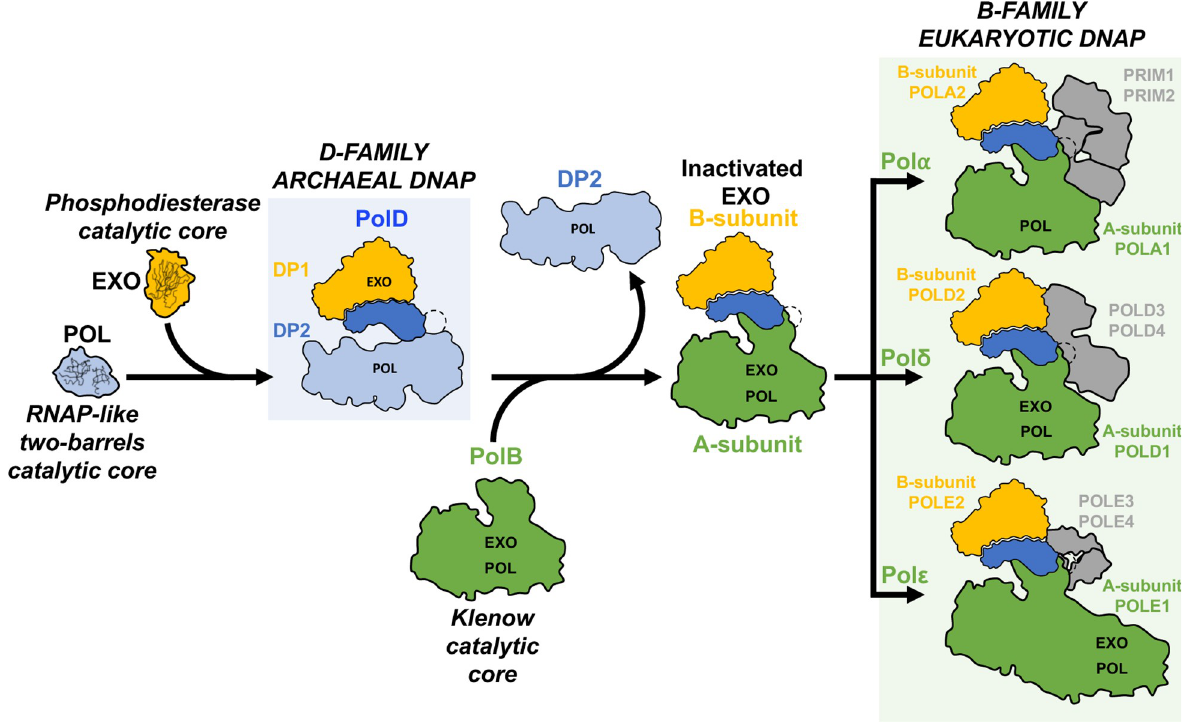
Fig 11. Hypothetical scenario accounting for the origins of archaeal PolD and its evolutionary relationships with the eukaryotic replicative DNAPs. Eukaryotic replicative DNAPs show a complex relationship with their archaeal ancestors, including contributions from both the B- and D- family of archaeal polymerases. During evolution, the D-family DP2 catalytic core was replaced by a B-family catalytic core in all eukaryotic replicative DNAPs, which are thus chimeric with respect to their archaeal homologues. Comparison of the PolD cryo-EM structure with the eukaryotic DNAPs shows that the eukaryotic A-subunit CTD/B-subunit complex has lost several features that are critical for the function of DP2– CTD/DP1 complex in PolD, suggesting the following hypothetical scenario that accounts for the evolutionary relationships between the archaeal PolD and the eukaryotic replicative DNAPs PolD has recruited an ancestral RNAP-like two-DPBB catalytic core for DNA replication. During evolution, the RNAP-like catalytic core of DP2 was substituted by a B-family-related catalytic subunit. The nuclease active site of DP1 was inactivated, as the proofreading activity is now carried on the catalytic subunit (A). While in PolD, the DP1/DP2–CTD complex contributes actively to DNA binding, and the eukaryotic A-subunit CTD/B-subunit complexes in Pol α , Pol δ , and Pol ε are involved in interacting with other members of the replication fork. cryo-EM, cryo–electron microscopy; CTD, C-terminal domain; DNAP, DNA polymerase; EXO, exonuclease active site; RNAP, RNA polymerase.